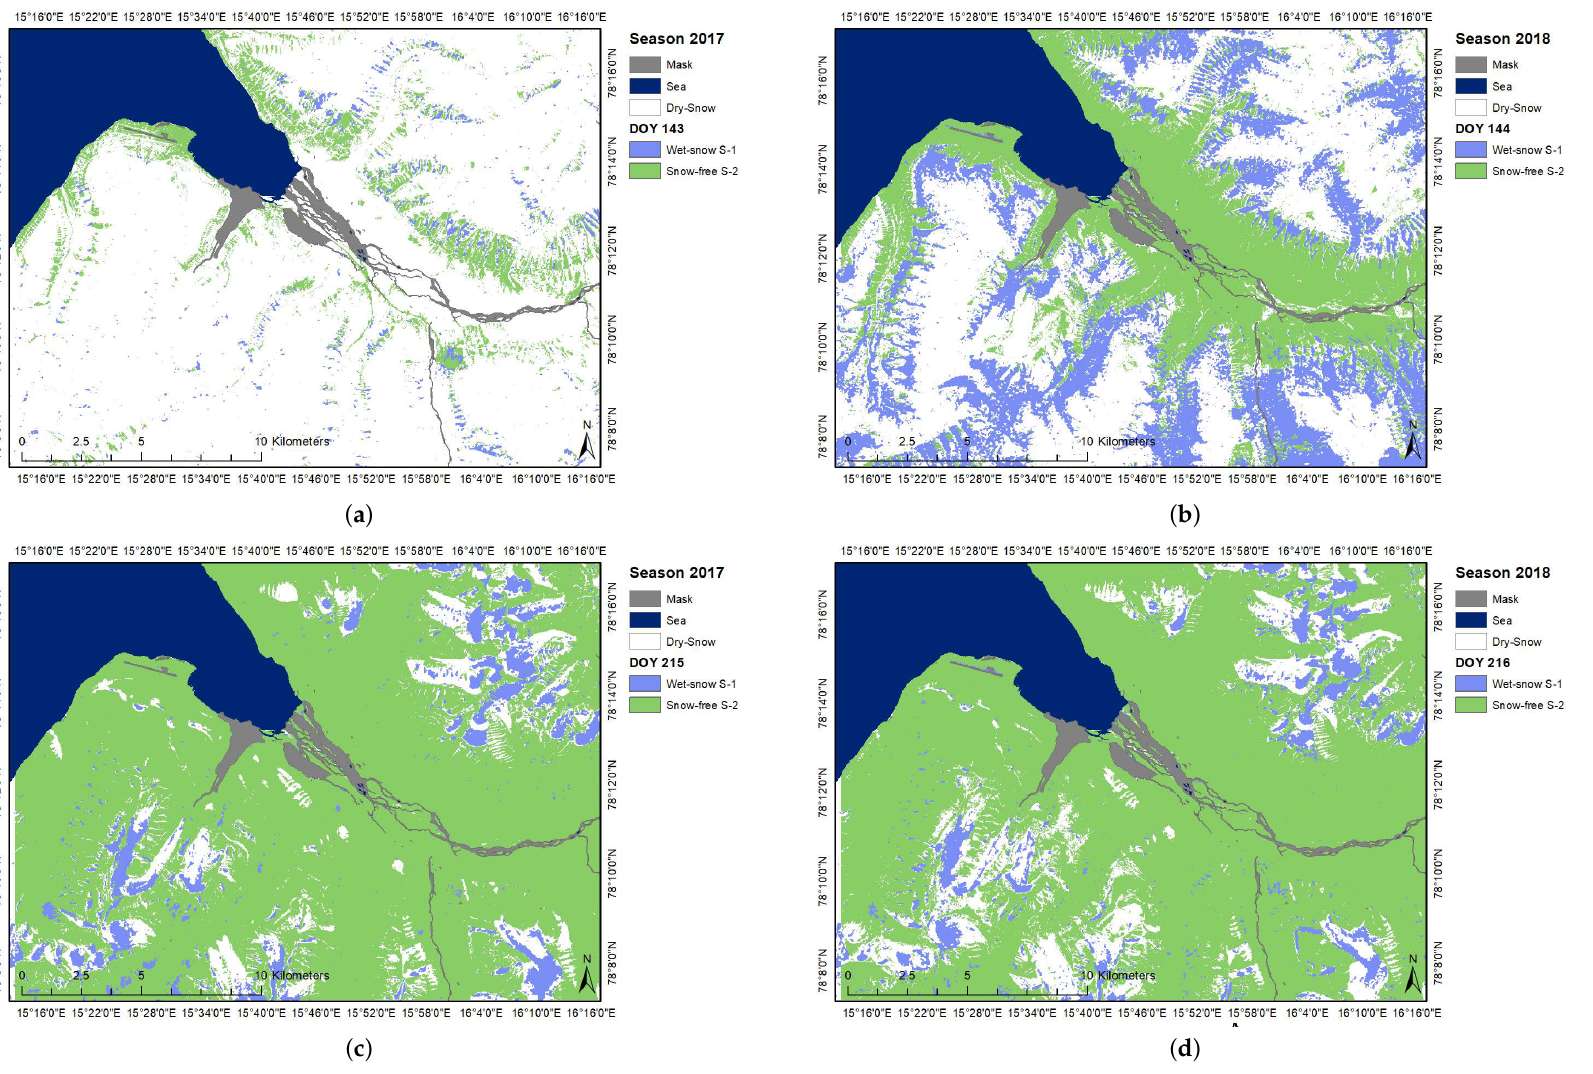
Figure 8. Snow cover classification of Sentinel-1 and Sentinel-2, based on backscatter and NDSI thresholds. The two maps at the top represent the month of May (DOY 143 2017 ( a ) and DOY 144 2018 ( b )). In the lower part represents the month of August (DOY 215 2017 ( c ) and DOY 216 2018 ( d